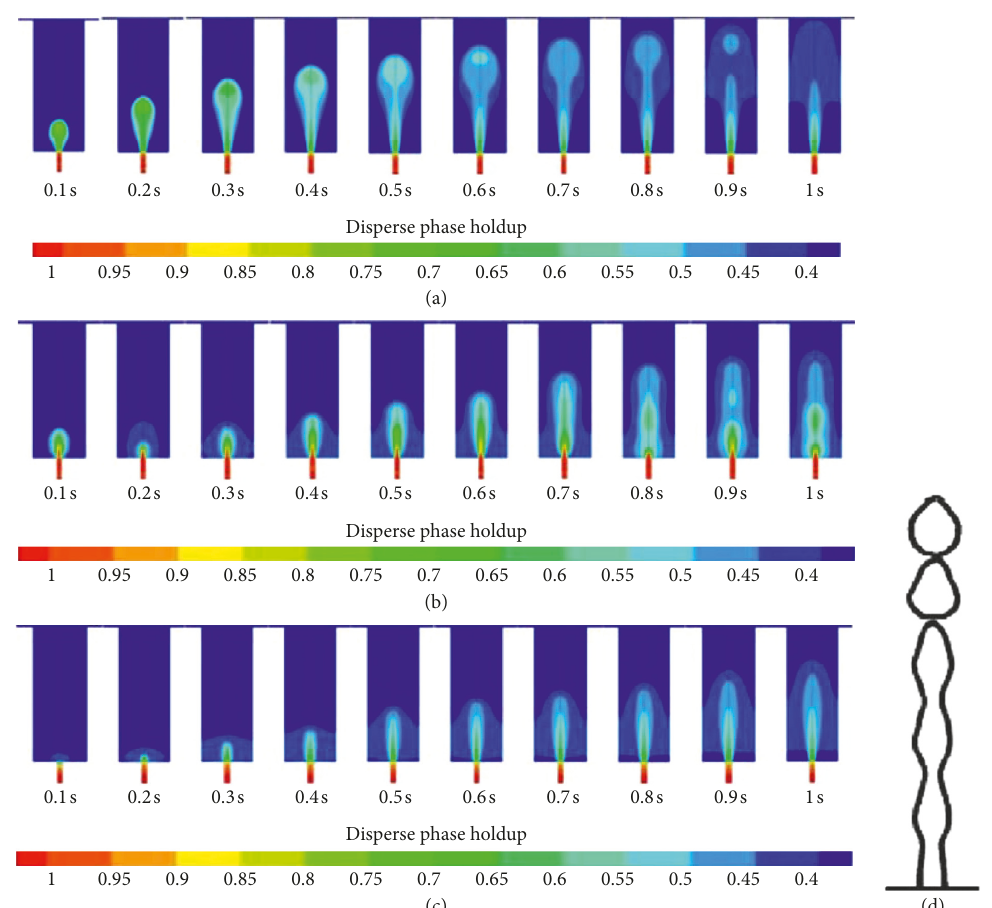
Figure 4: Comparison of the spray process from 0.1s to 1s using (a) CM. (b) DQMOM and (c) QMOM with the (d) the simulation results predicted by Bright